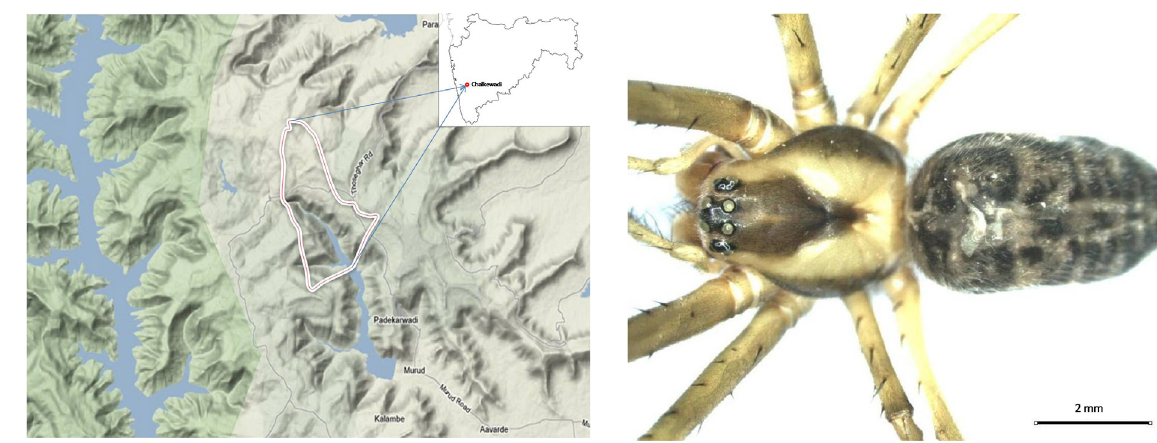
globular and bending outwards in T. ventralis (see Jäger & Praxaysombath 2009, fig.29); CD not overlapping FD but run adjacently (fig. 3) (similar arrangement seen in T. cylindrata (Wang, 1991)); two diffuse broad yellowish line on the mid-dorsum not present in T. ventralis .